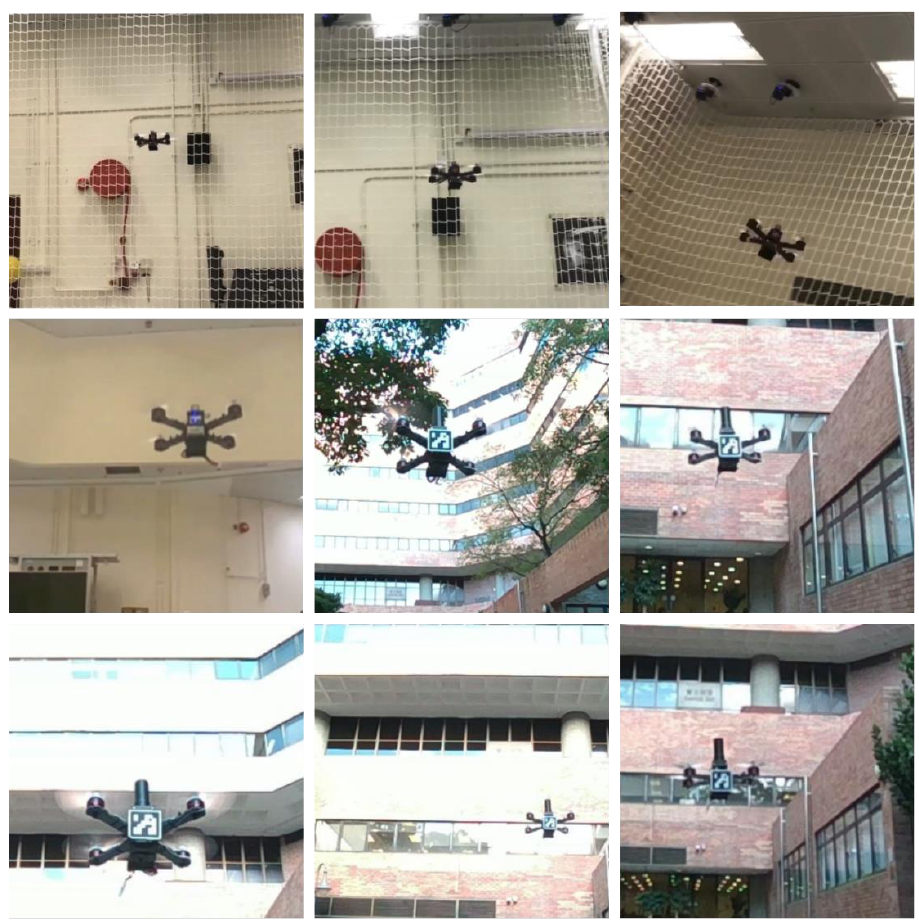
Figure 4. Examples of the training dataset.